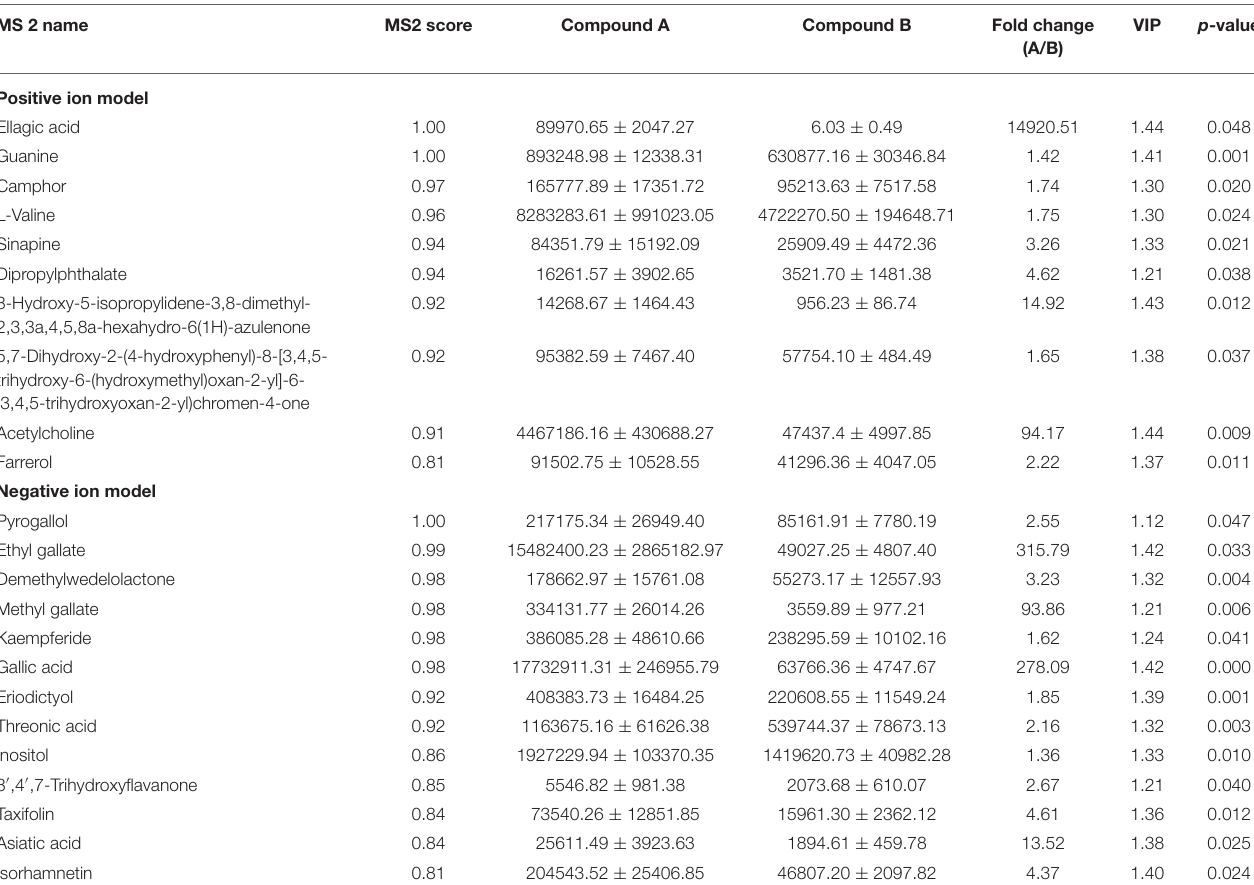
TABLE 3 | Information of differential metabolites with fold change (A/B) large than